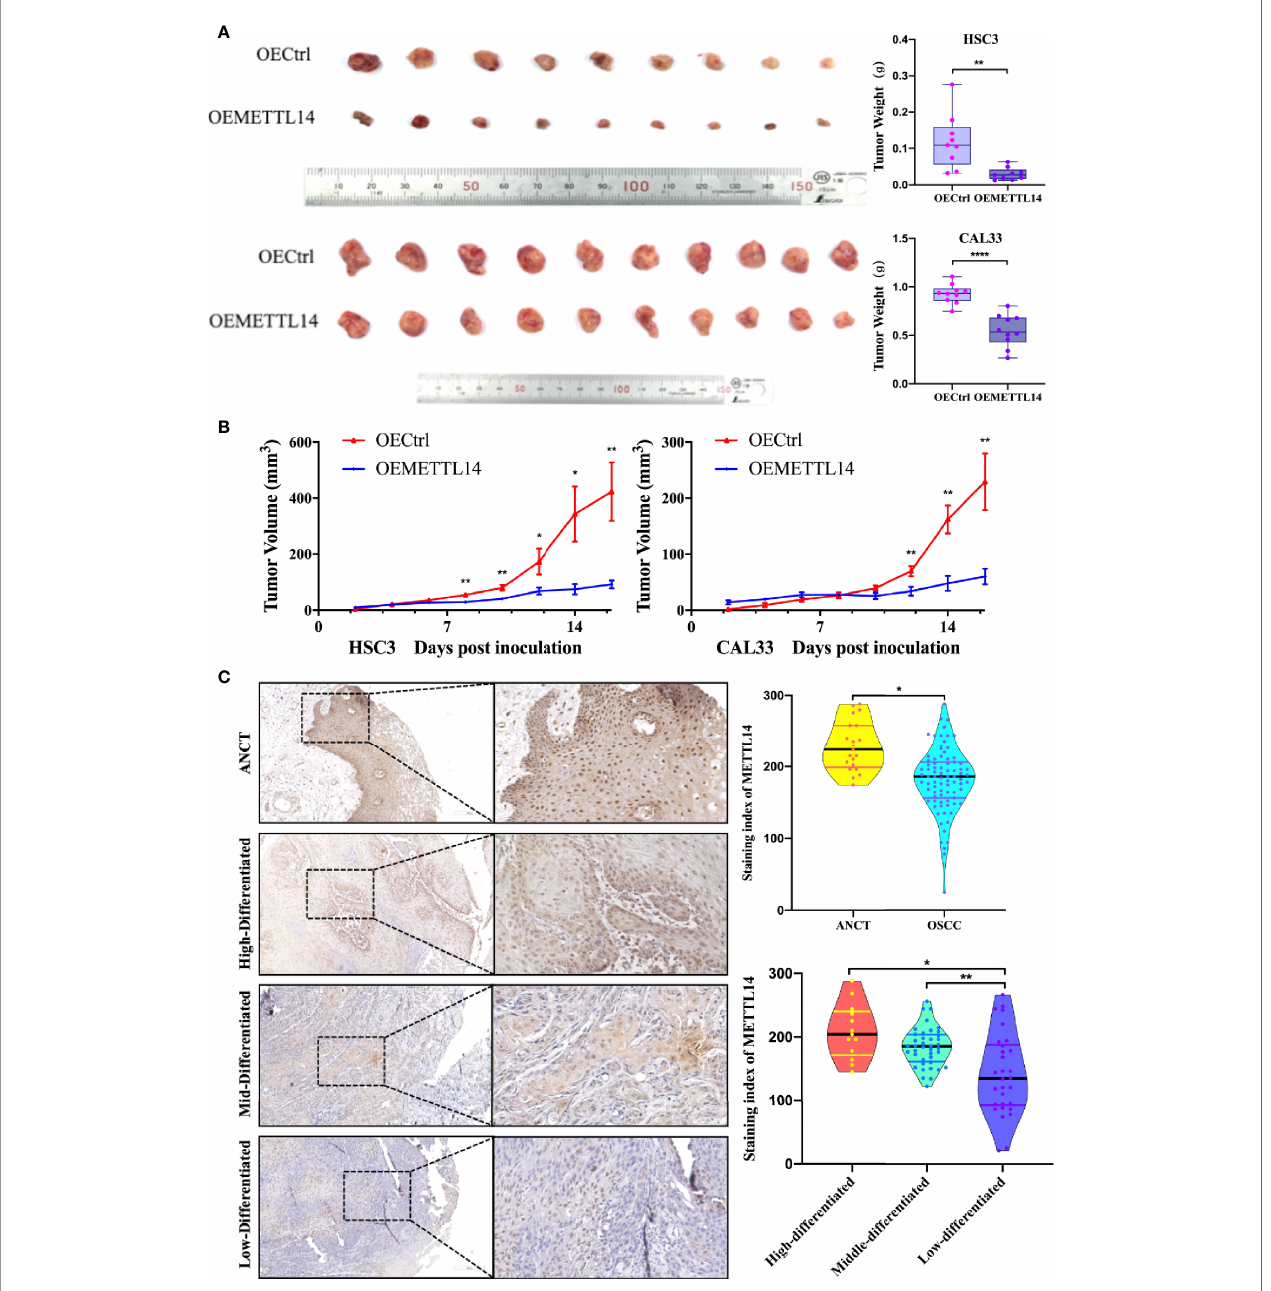
FIGURE 5 | METTL14 expression in vivo . (A) Growth and weight of tumor xenografts (two weeks) in NOD/SCID mice subcutaneously injected with 5 × 10 7 HSC3 or CAL33 cells transfected with OECtrl or OEMETTL14. (B) Volume of tumor xenografts in NOD/SCID mice calculated every two days [V = (length × width 2 /2)]. (C) Representative immunohistochemistry images and correlations of METTL14 in ANCT and OSCC tissues with different pathological differentiations. ( p or adjusted- p *< 0.05, **< 0.01, ***< 0.001, ****<